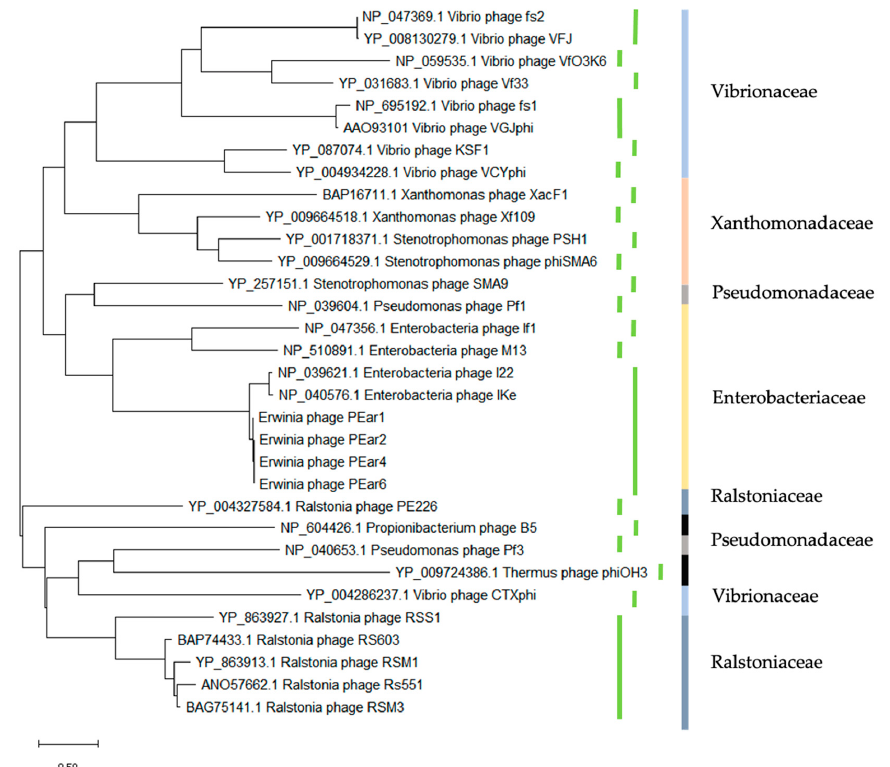
Figure 3. Phylogenetic analysis of filamentous phages based on the pIII amino acid sequence. Green bars represent the different genera as determined by the International Committee on Taxonomy of Viruses (ICTV). Colored bars indicate the bacterial families that the respective filamentous phage can infect (light blue Vibrionaceae, orange Xanthomonaceae, gray Pseudomonadaceae, yellow Enterbacteriaceae, dark blue Ralstoniaceae and black other bacterial families). This analysis shows that based on the pIII sequence, phages cluster according to the phylogenetic diversity of their host.